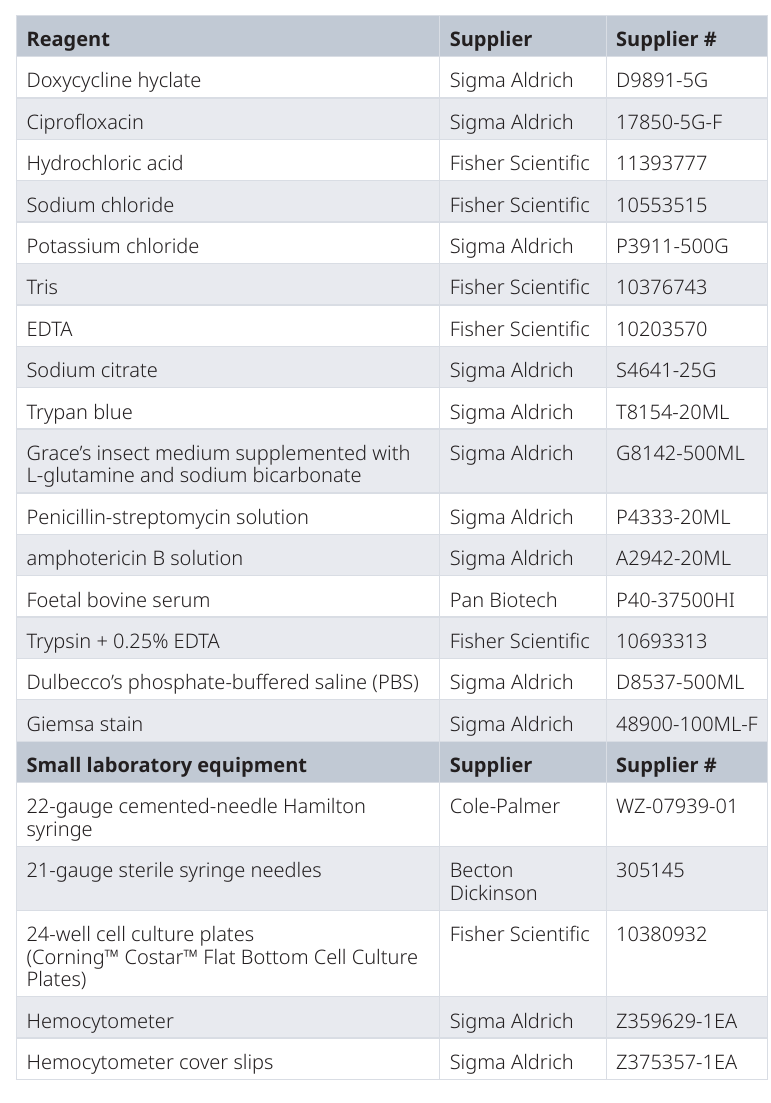
Table 2. Reagents and small laboratory equipment used in this